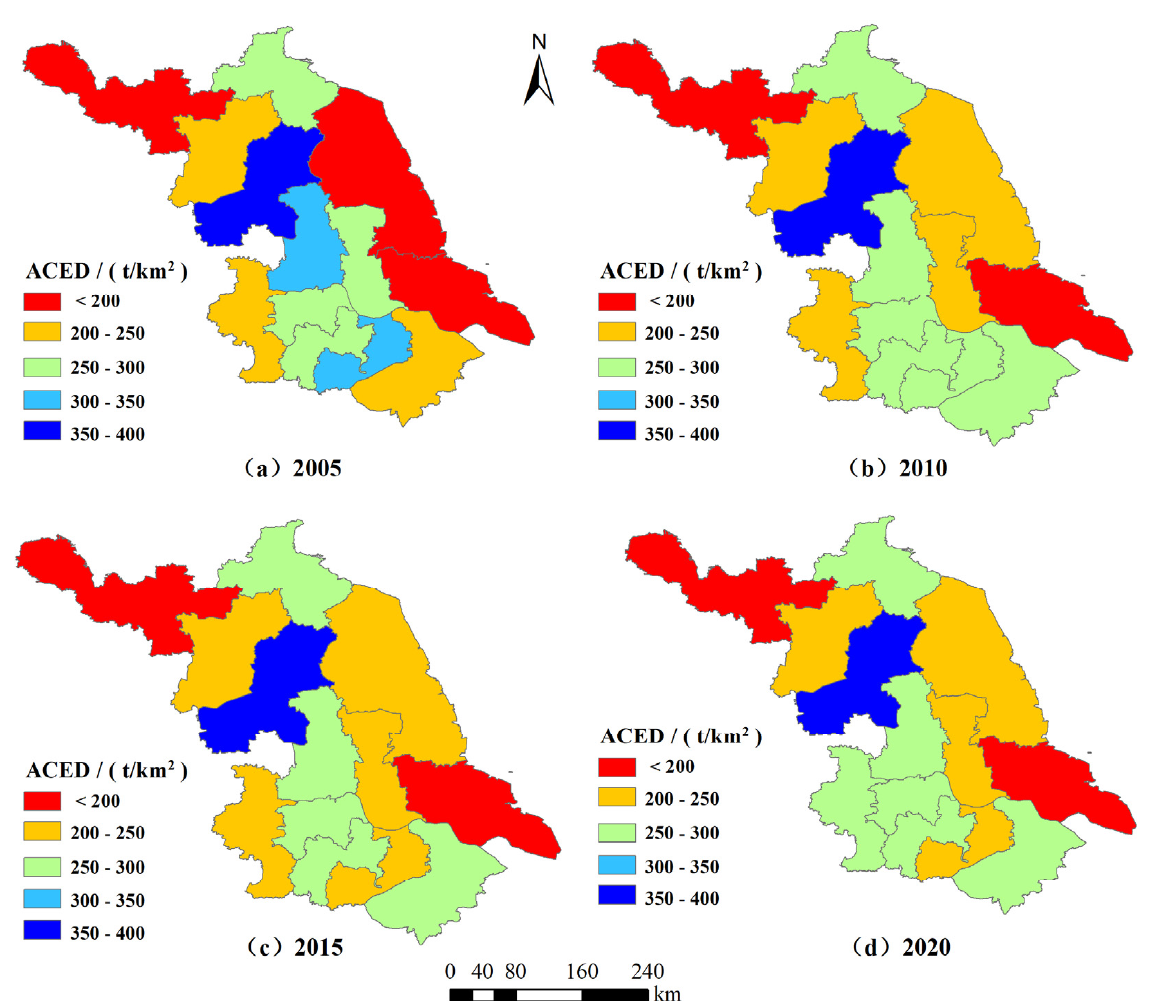
Figure 5. Evolution of spatial pattern of ACED in Jiangsu Province, China.